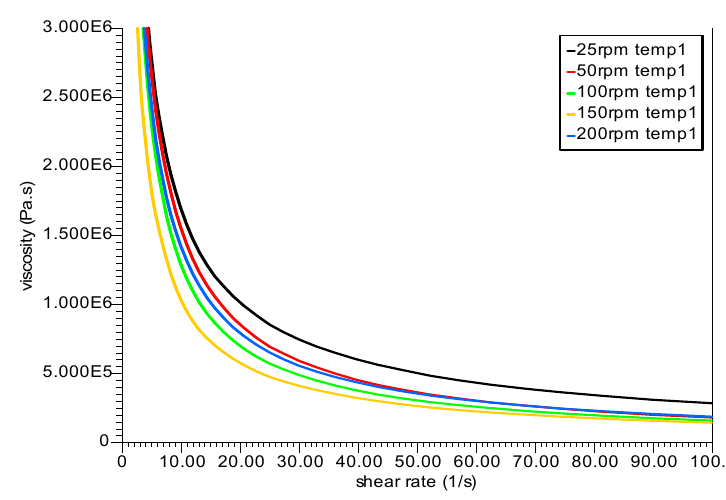
Figure 8. Viscosity ( η ) versus shear rate (1/s) for novel SSB ® 55 Pharma grade Shellac at various screw speeds.